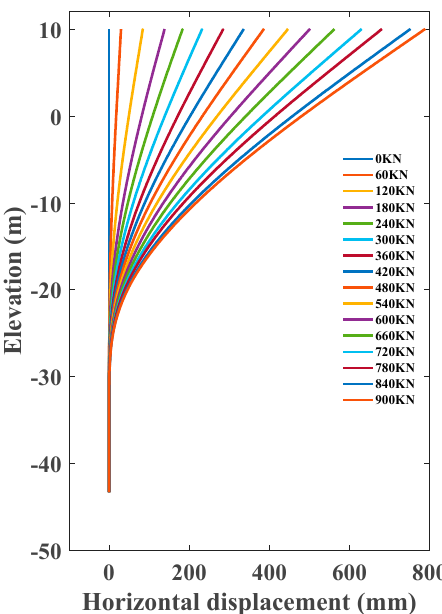
Figure 10. Distributed displacement values at FUT1 direction.